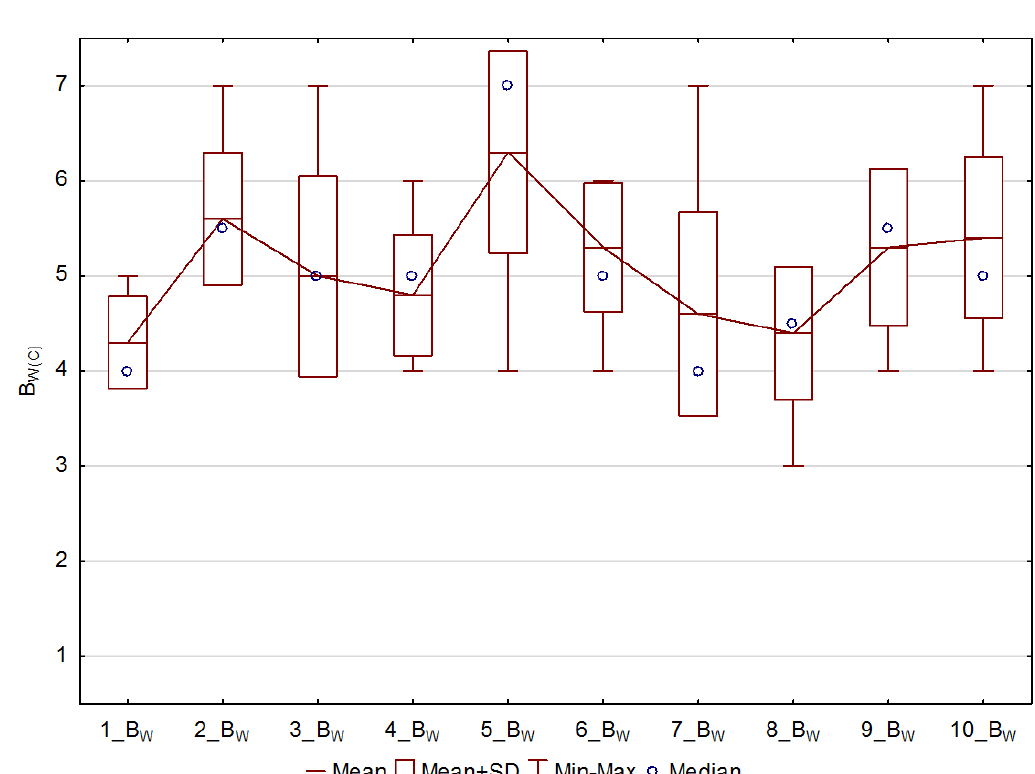
Figure 20. Wall brightness perception for group C.